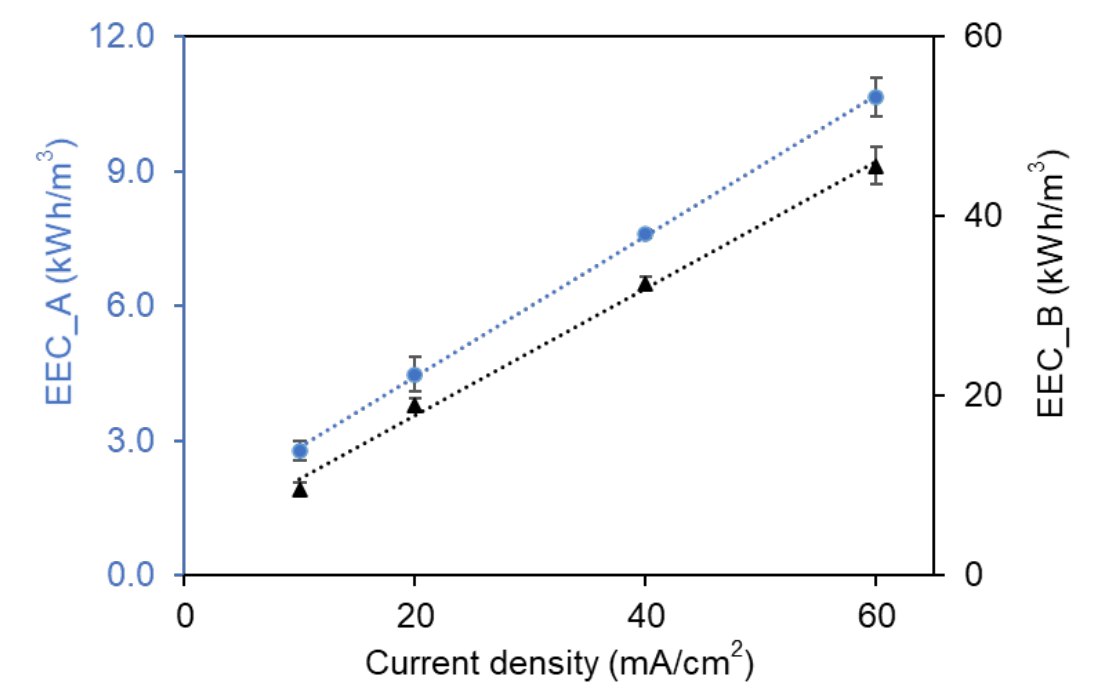
Figure 7. Energy consumption required for 100% MB (50 mg/L) degradation in 0.17 M Na 2 SO 4 + 2 g/L NaCl (EEC_A) and for 70% MB (50 mg/L) degradation in 0.17 M Na 2 SO 4 in the absence of Cl – ions (EEC_B) in a current density range of 10–60 mA/cm 2 .